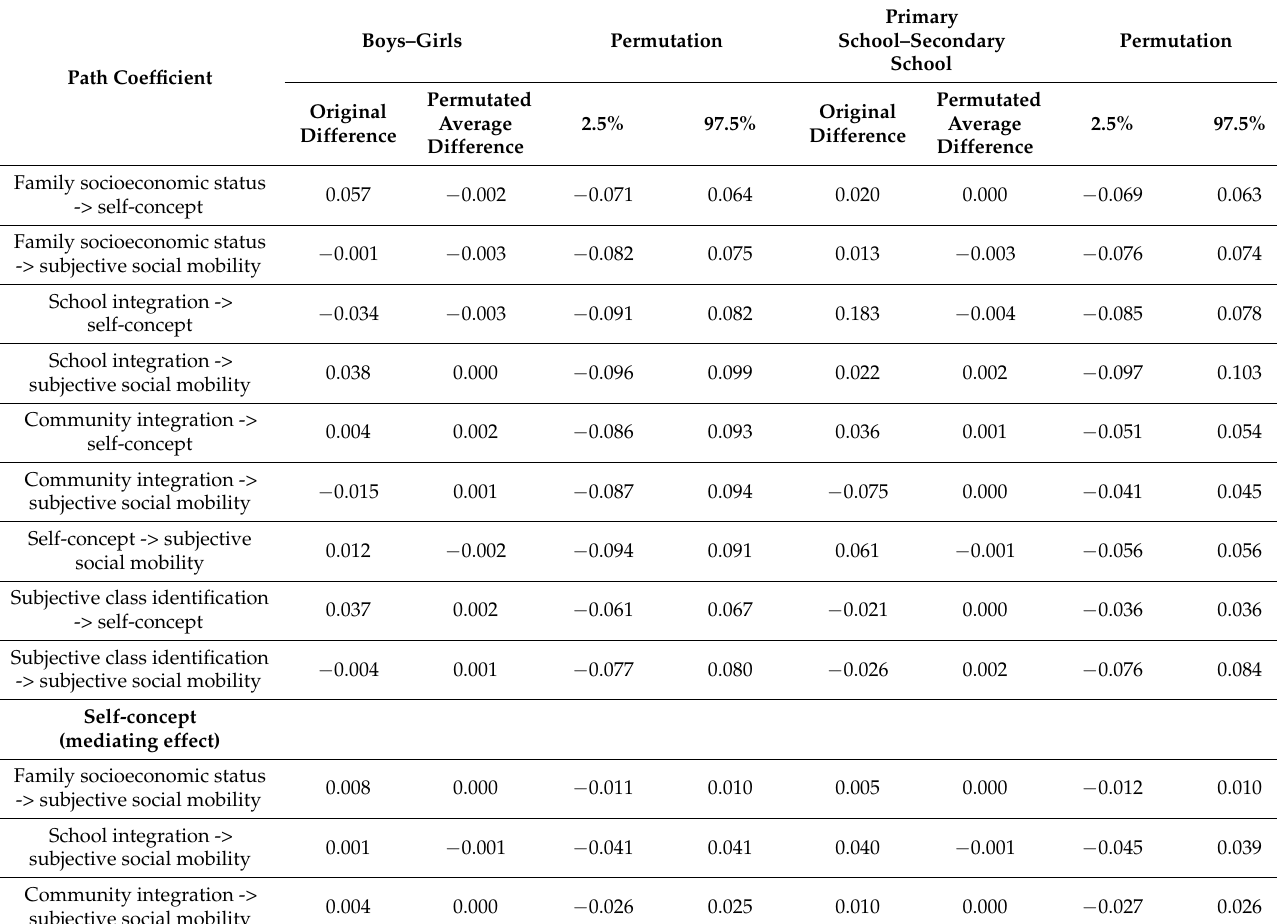
Table 9. Comparison of path coefficients and intermediary effects of